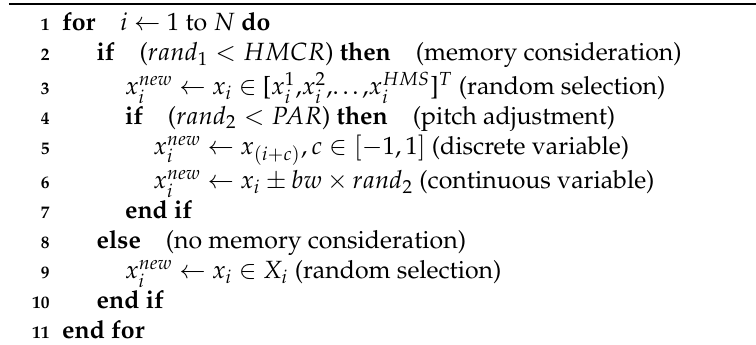
Algorithm 1: HS search process for new